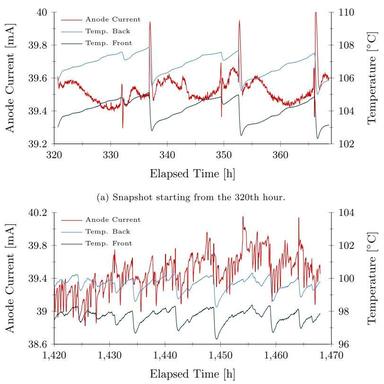
48-h snapshots of the anode current and thruster temperatures at the beginning of stable operation and near the end of the test. Data are processed to a temporal resolution of 100 s using a mean-based approach.